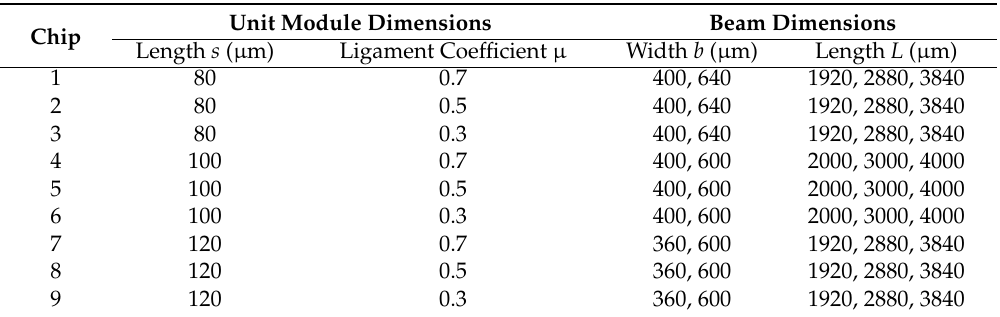
Table 5. Dimensions of the test micro-beams and unit modules. The beam thickness ( h ) is 10 µ m and the gap ( g ) between the beam and ground is 2 µ m.